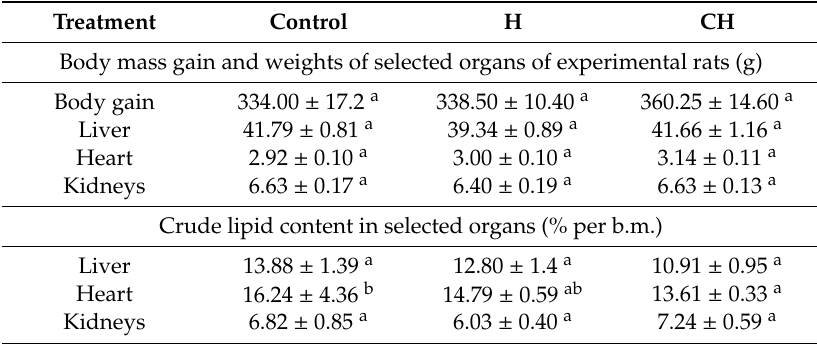
Table 4. Body mass and weights of selected organs (g / kg